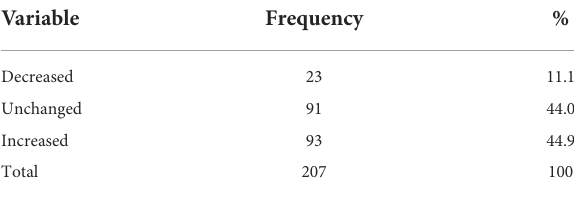
TABLE 5 Summary statistics of the amount of money spent on food